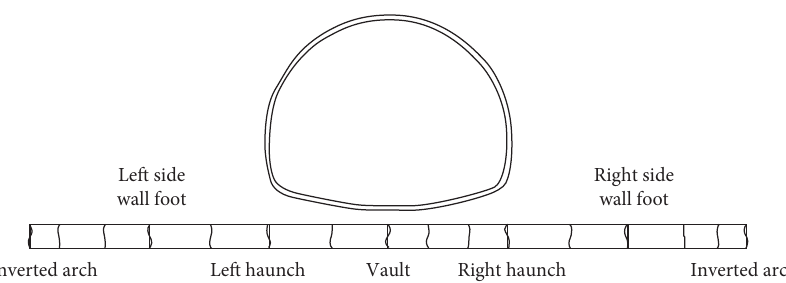
Figure 13: Distribution of lining cracks of the steel fiber reinforced